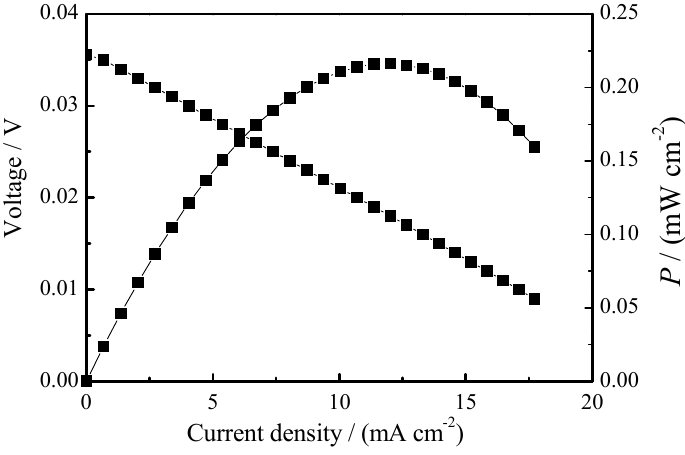
Figure 7. The oxygen concentration discharge cell: air, Pd-Ag | 8YSZ-20% glass (700 °C) | Pd-Ag, O 2 at 800 °C.